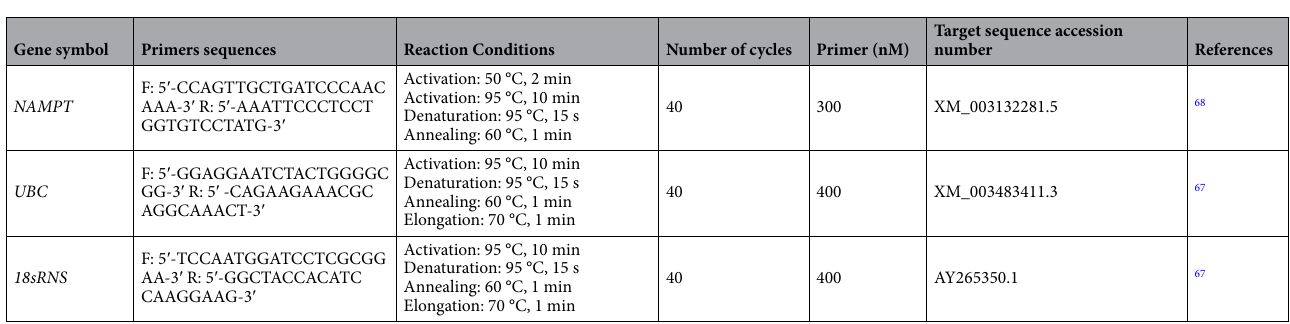
Table 1. Characteristics of primers used in the study. NAMPT visfatin , UBC Ubiquitin C , 18sRNA 18S ribosomal RNA , F forward, R